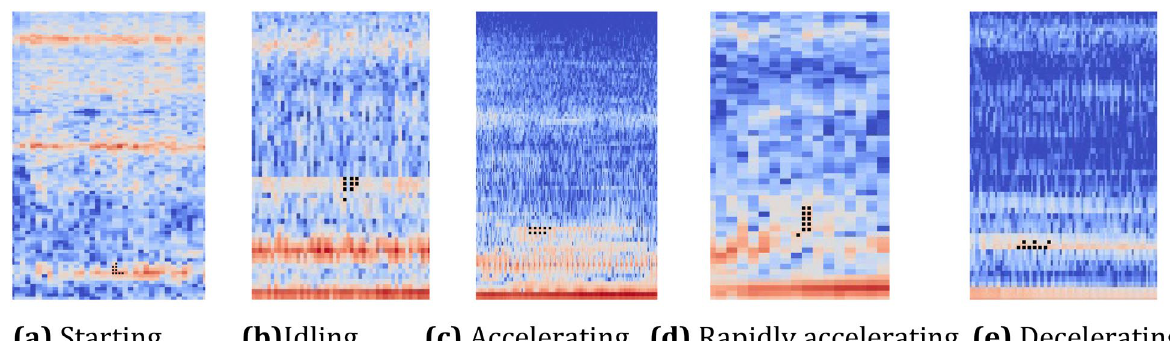
Figure 5. Sampling position of DFMRB in logarithmic Mel